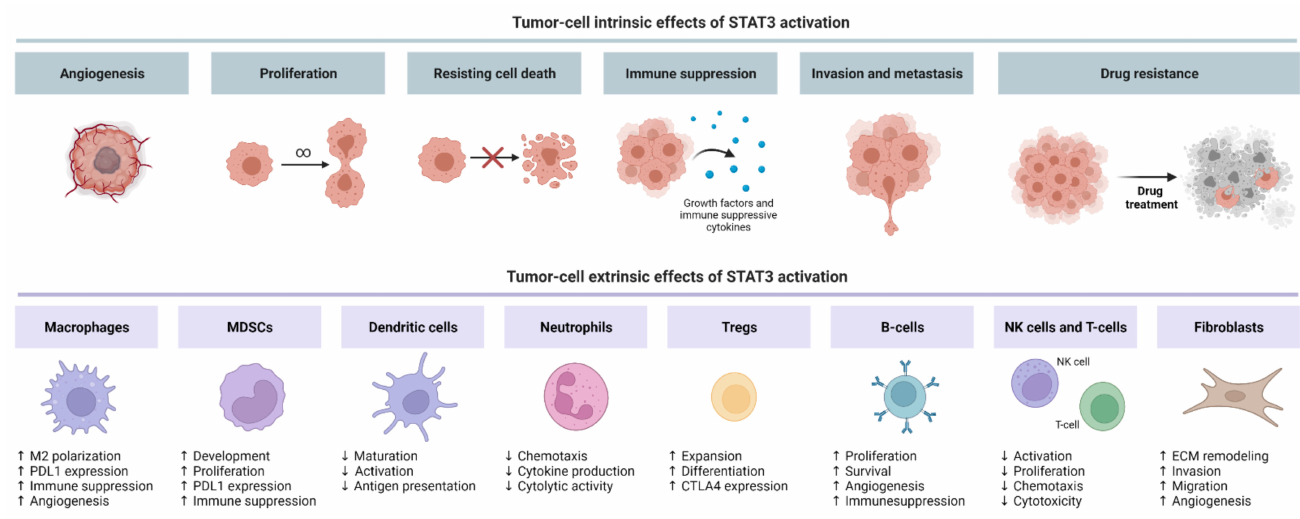
Figure 3. Tumor promoting effects of STAT3 activation in NSCLC. Tumor-cell intrinsic effects of STAT3 activation include angiogenesis, proliferation, immune suppression, invasion, and metastasis. Meanwhile, tumor-cell extrinsic activation of STAT3 in immune and stromal cells favors an immunosuppressive tumor microenvironment that inhibits the activation and recruitment of cytotoxic effector cells. Figure created in